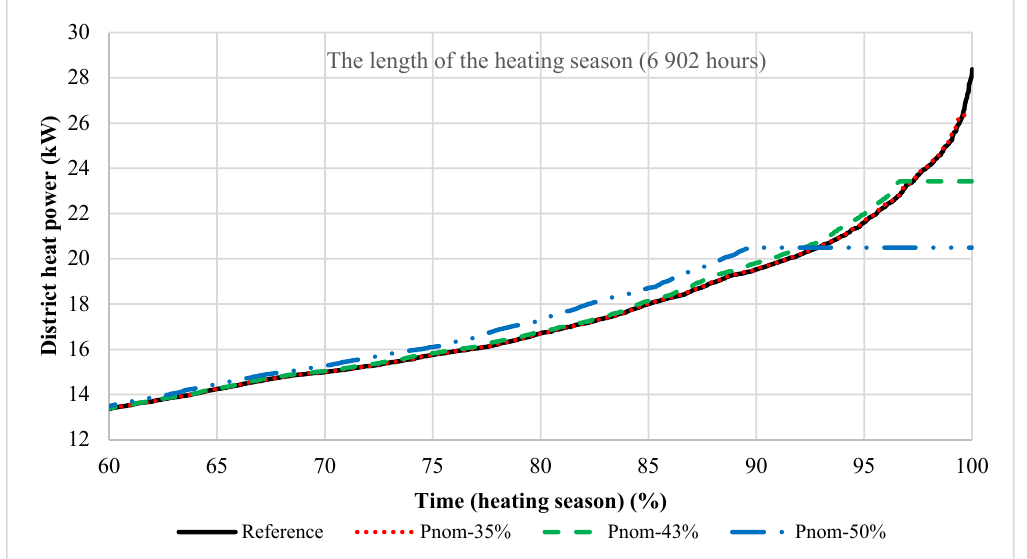
Figure 11. The duration of DH power demand of space heating and ventilation in the reference and peak demand limiting cases.